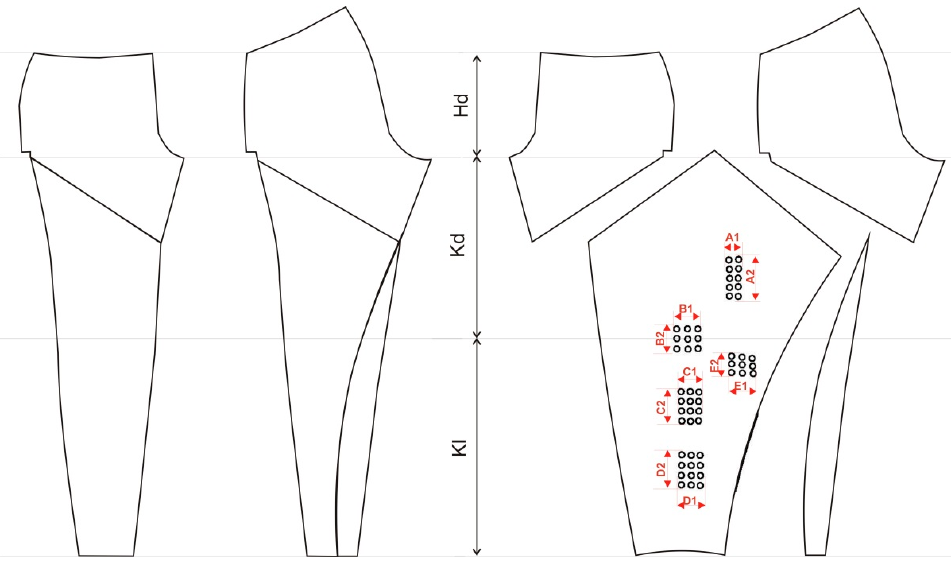
Figure 8. Cutting parts for 3D printing of protectors by incorporating textile material into the